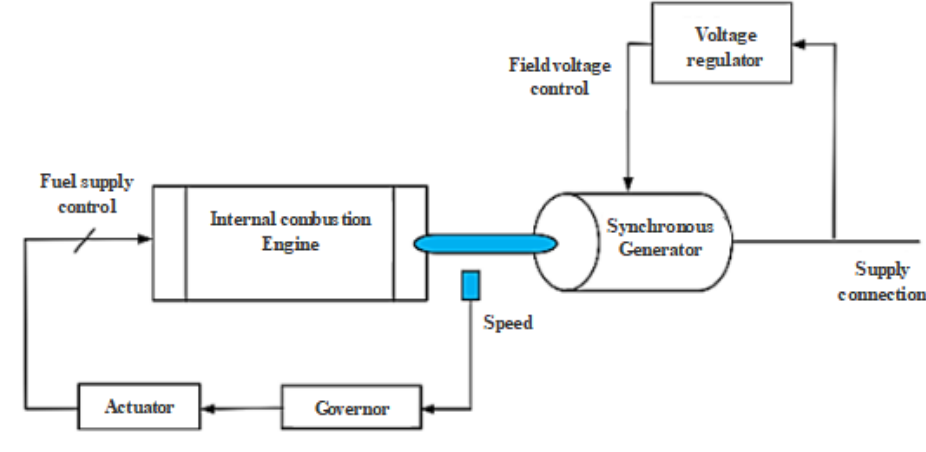
Figure 6. Schematic diagram of the diesel